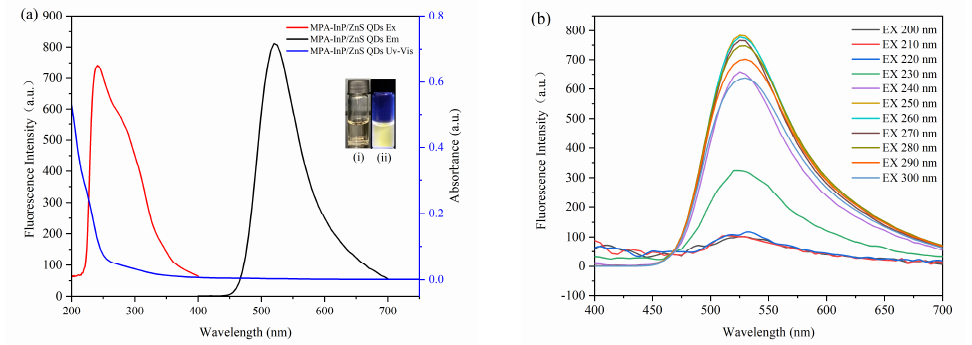
Figure 3. The absorption spectrum, excitation, and emission spectroscopy ( a ). (insert: photos of MPA-InP/ZnS QDs solutions under sunlight ( i ) and UV light (365 nm)) ( ii ) Emission spectroscopy with different excitation of MPA-InP/ZnS QDs ( b ). MPA-InP/ZnS QDs: mercaptopropionic acid capped InP/ZnS quantum dots.